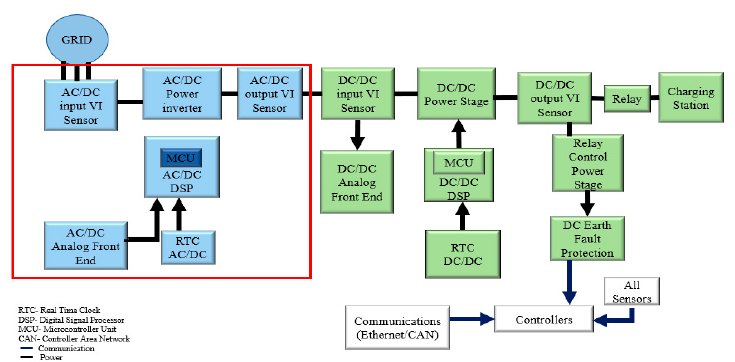
Figure 1. Block diagram of DC XFC Charger connected to the grid [14] .